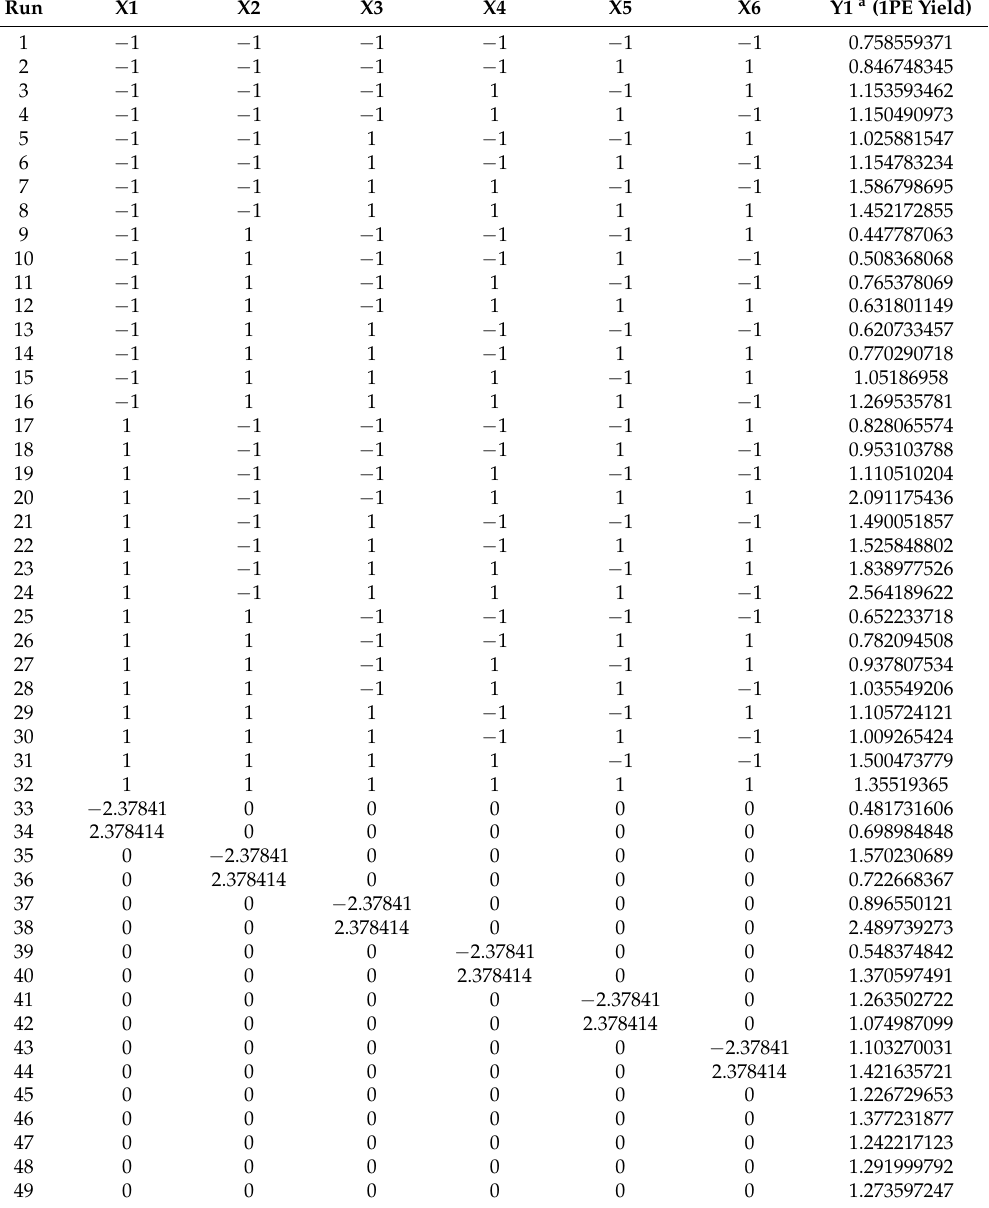
Table 2. Response surface methodology for different conditions of 1PE production and 1PE